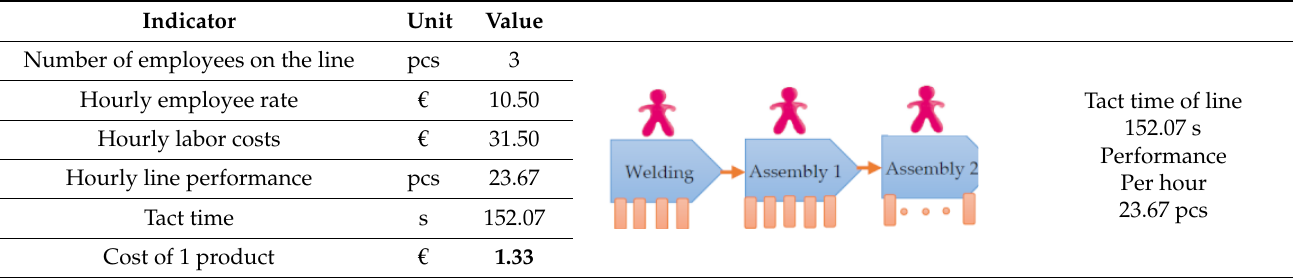
Table 11. Calculation of labor costs for one product in the analysis of individual operations of production line workplaces.